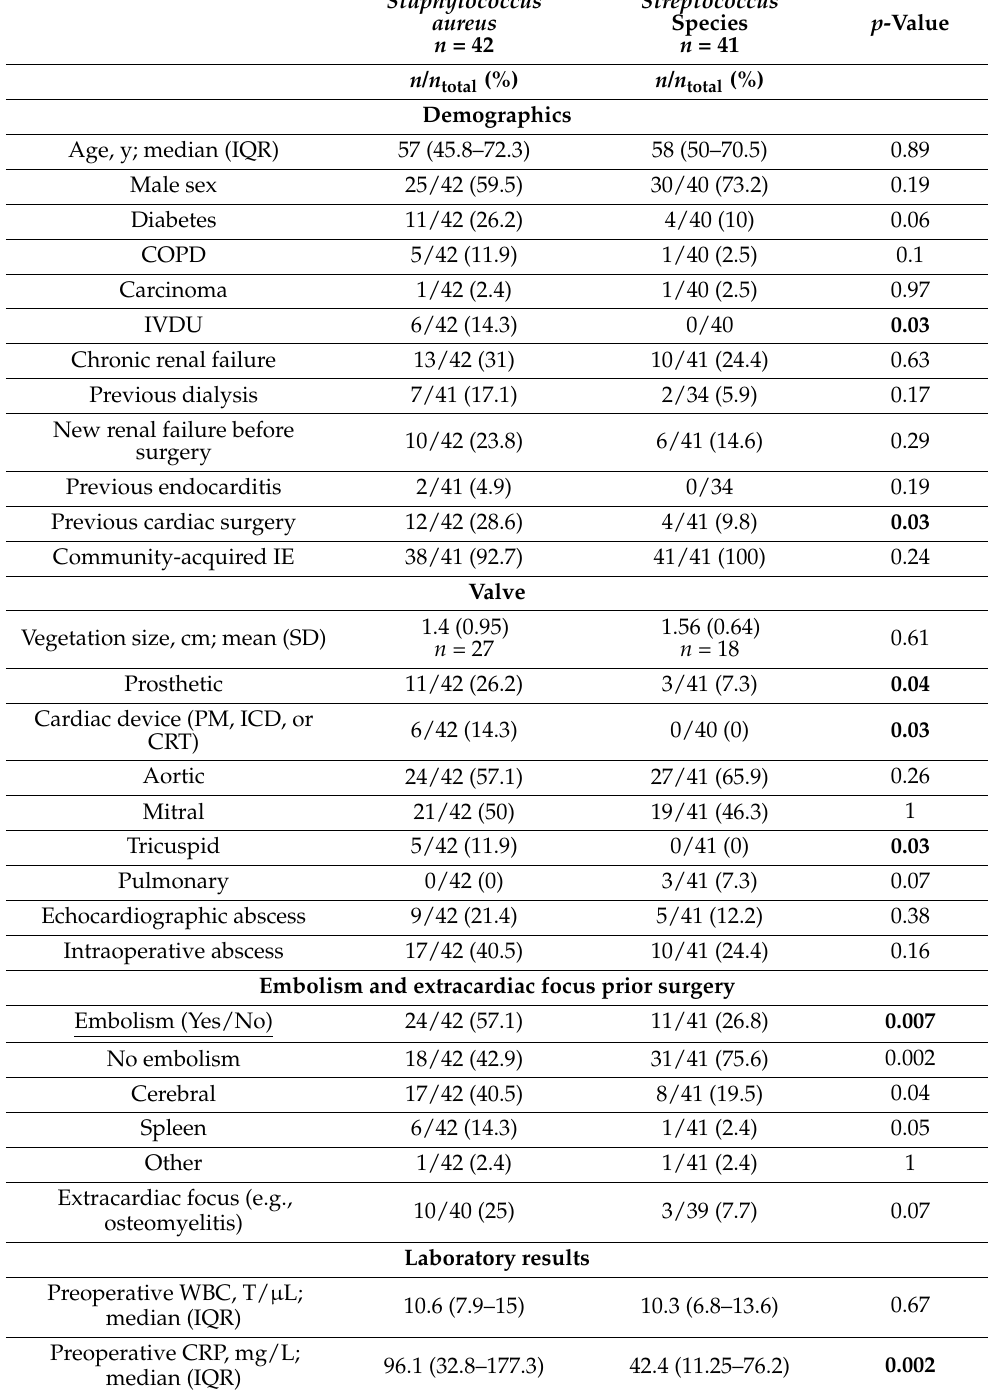
Table 1. Demographics and clinical characteristics of patients with infective endocarditis treated surgically and caused by Staphylococcus aureus or Streptococcus